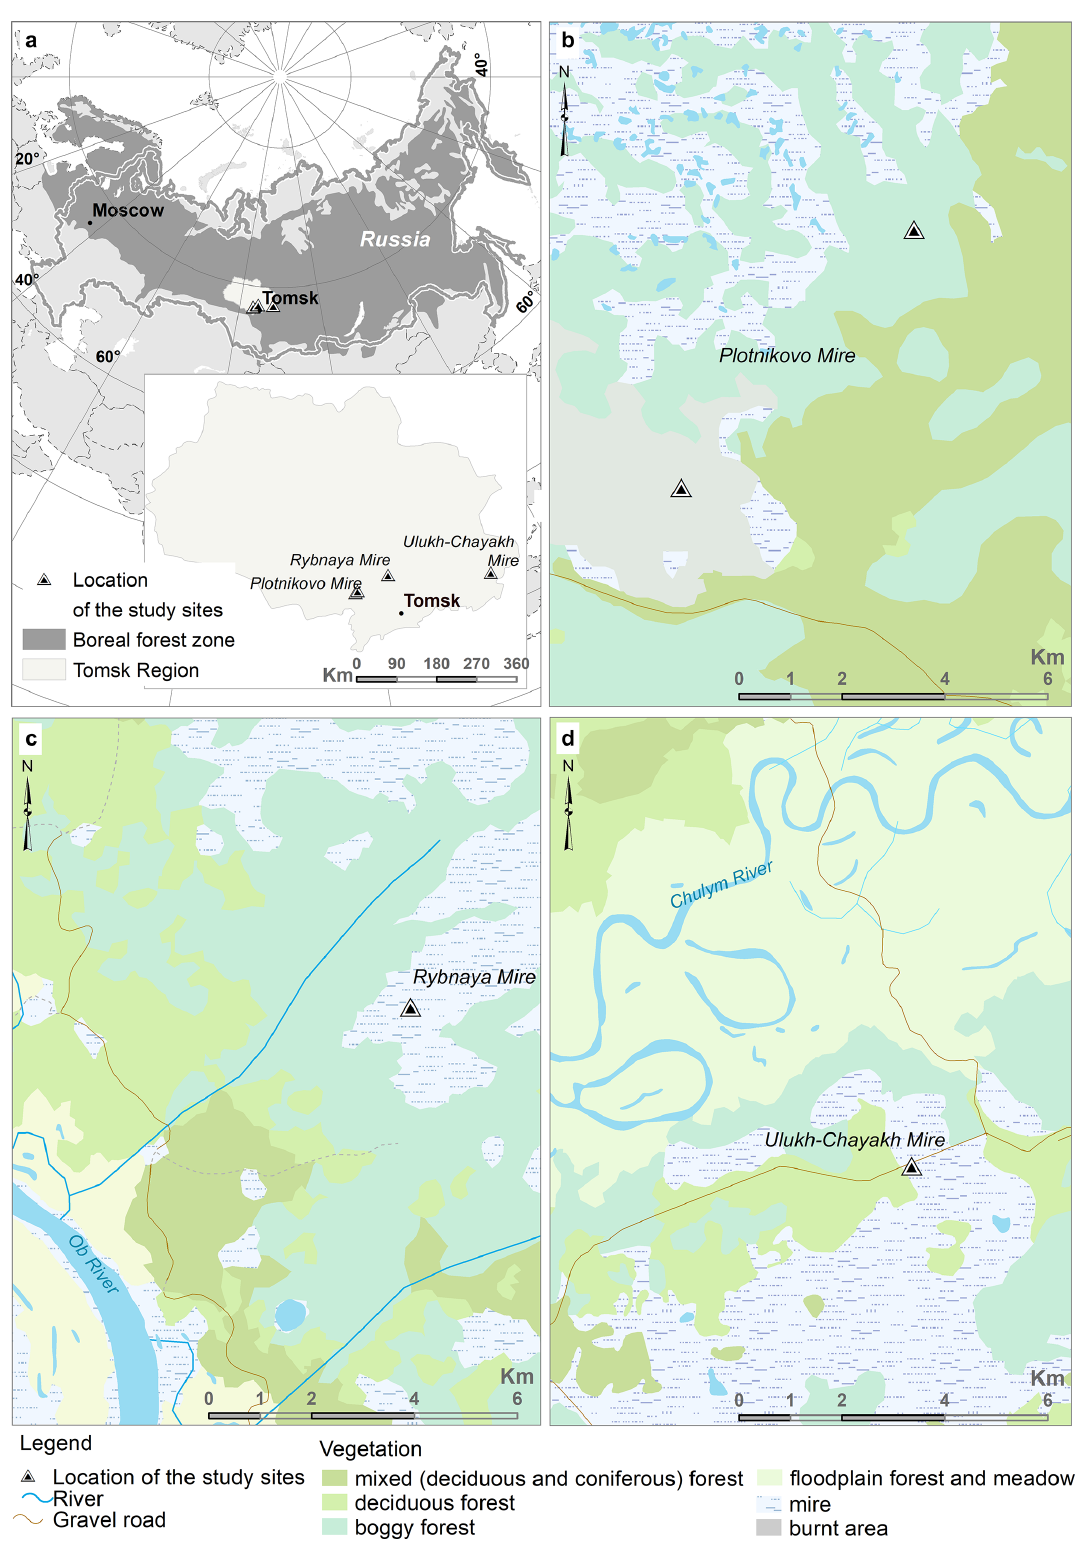
Figure 1. Location of the study area in Eurasia, Russia, and the Tomsk region (a) . Satellite-based images showing the location and spatial extent of vegetation types and the fire event at the previously published sites on the Plotnikovo Mire ( b ; Feurdean et al., 2020a) as well as the new study sites: Rybnaya (c) and Ulukh–Chayakh (d) .